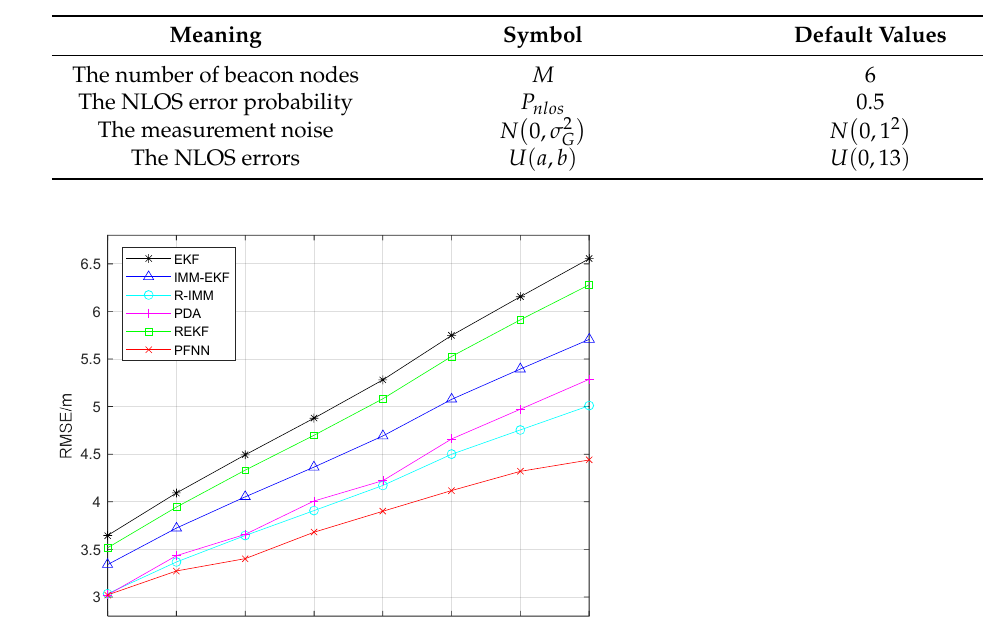
Figure 5. The CDF of the localization error. Table 2. Uniform distribution parameter.